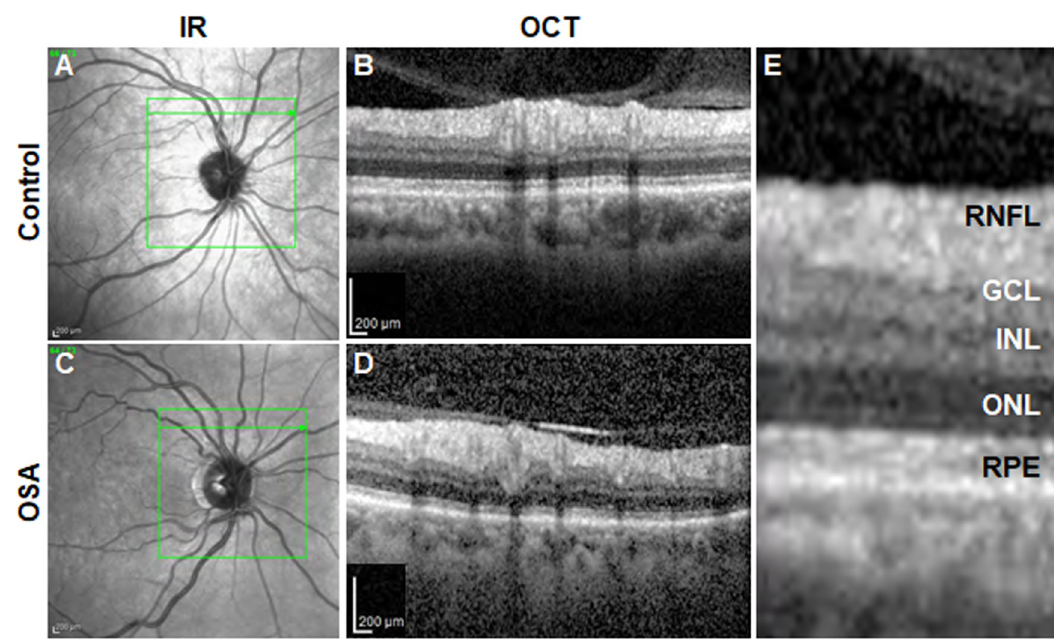
Fig 2. Retinal cell layers visible within the retinal nerve fiber layer (RNFL) scans. Each patient underwent multiple scans around the optic nerve head to obtain morphological information of the retinal cell layers in this region. (A) Representative infrared (IR) image depicting the region where the scans were collected (green square) in a control patient. (B) Representative optical coherence tomography (OCT) image from the control patient highlighting one measurement (green arrow in A) collected for examining the retinal morphology. (C) Representative IR image depicting the region where the scans were collected (green square) in a patient with OSA. (D) Representative OCT image from the OSA patient highlighting one measurement (green arrow in C) collected for examining the retinal morphology. (E) High magnification OCT image from B with all retinal cell layers identified. GCL, ganglion cell layer; INL, inner nuclear layer; ONL, outer nuclear layer; RPE, retinal pigment epithelium. Scale bar: 200 μ m.